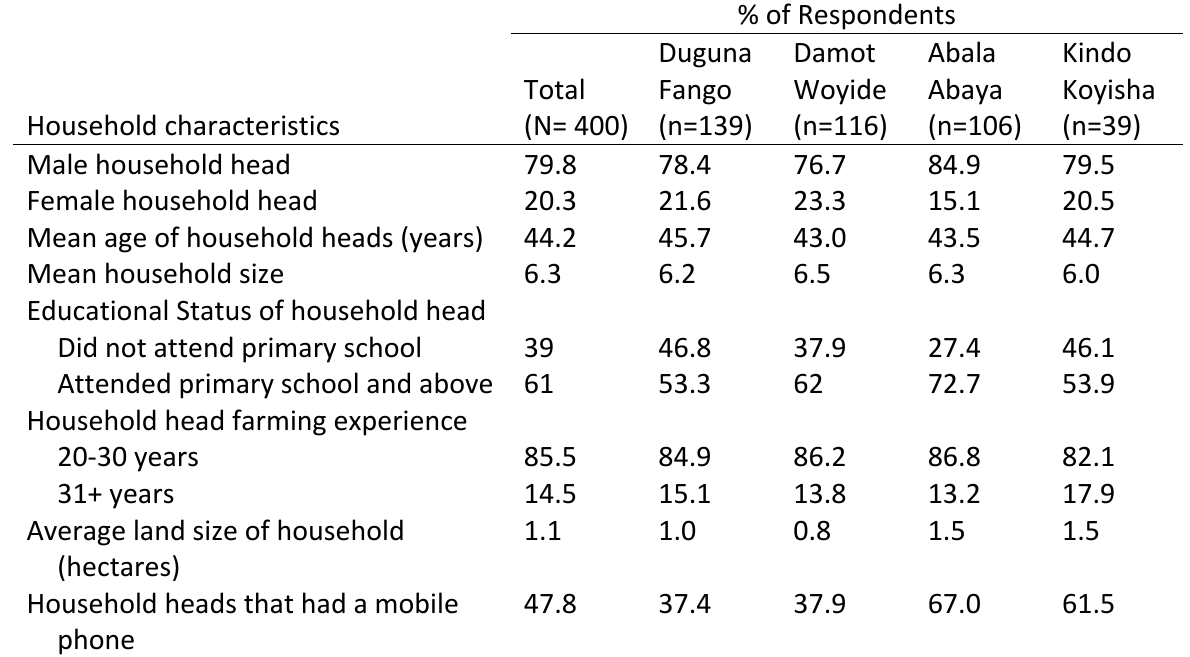
Percentage Distribution of Farmers by District and Selected Demographic and Socio-economic Characteristics (N =